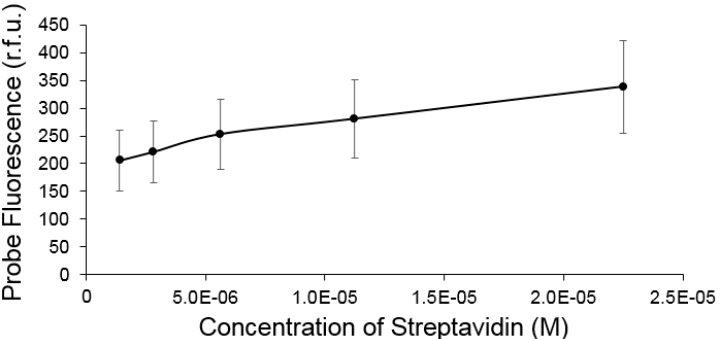
Figure 4. The fluorescence intensity of the IR783-VSHPQAPF was observed to increase linearly with increasing concentrations of streptavidin.